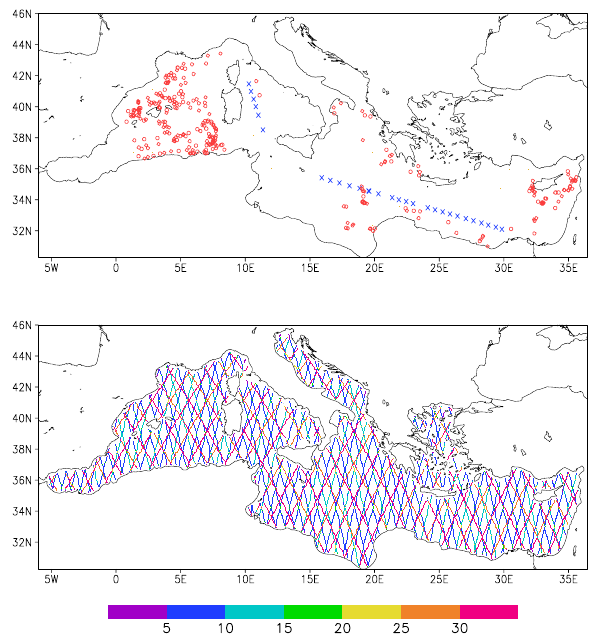
Fig. 1. Number of SLA and in situ observations in the Mediter- ranean during 2009. Top panel shows the position of Argo (red open circles) and XBT (blue crosses) profiles in the year 2009, while the bottom panel shows the number of SLA observations along tracks from both Jason and Envisat satellites during 2009. Each Argo and XBT profile was performed only